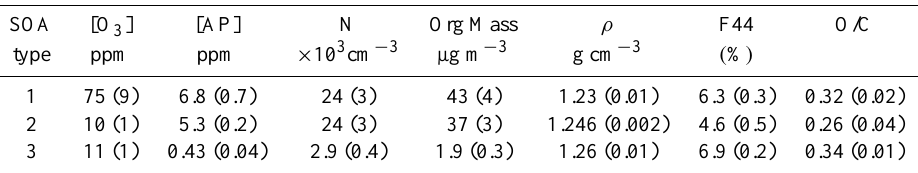
Table 1. SOA precursor mixing ratios and particle properties. F44 values are percentages of the fragment m/z 44 of total organic mass concentrations in the AMS mass spectrum. Values in brackets are one standard deviation of mean values. O/C ratios were calculated from F44 values (Aiken et al.,